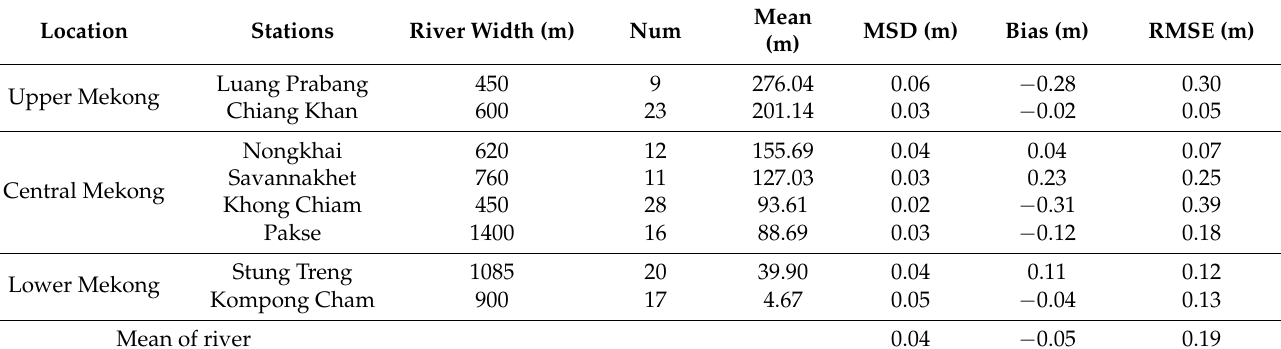
Figure 3. Comparison between ICESat-2 water level data (blue dot) and daily in situ water level data (gray straight line) in the Mekong River at different hydrological stations. The time span was from October 2018 to June 2021 (( a ) Luang Prabang, ( b ) Chiang Khan, ( c ) Nongkhai, ( d ) Savannakhet, ( e ) Khong Chiam, ( f ) Pakse, ( g ) Stung Treng, ( h ) Kompong Cham). Table 1. Accuracy indicators of ICESat-2 water level data for the Mekong River.